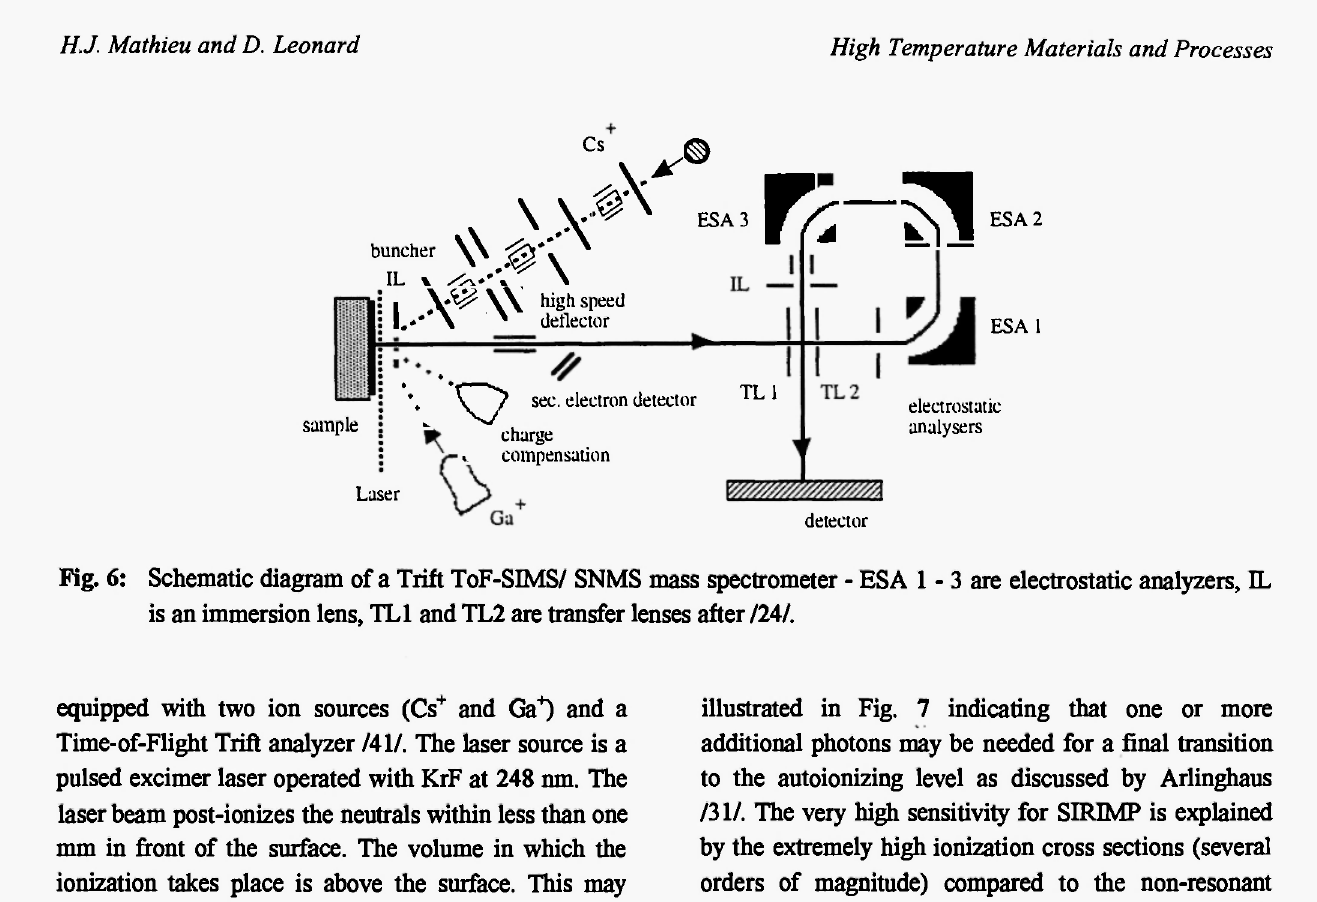
Fig. 6: Schematic diagram of a Trift ToF-SIMS/ SNMS mass spectrometer - ESA 1 - 3 are electrostatic analyzers, IL is an immersion lens, TL1 and TL2 are transfer lenses after /24/.